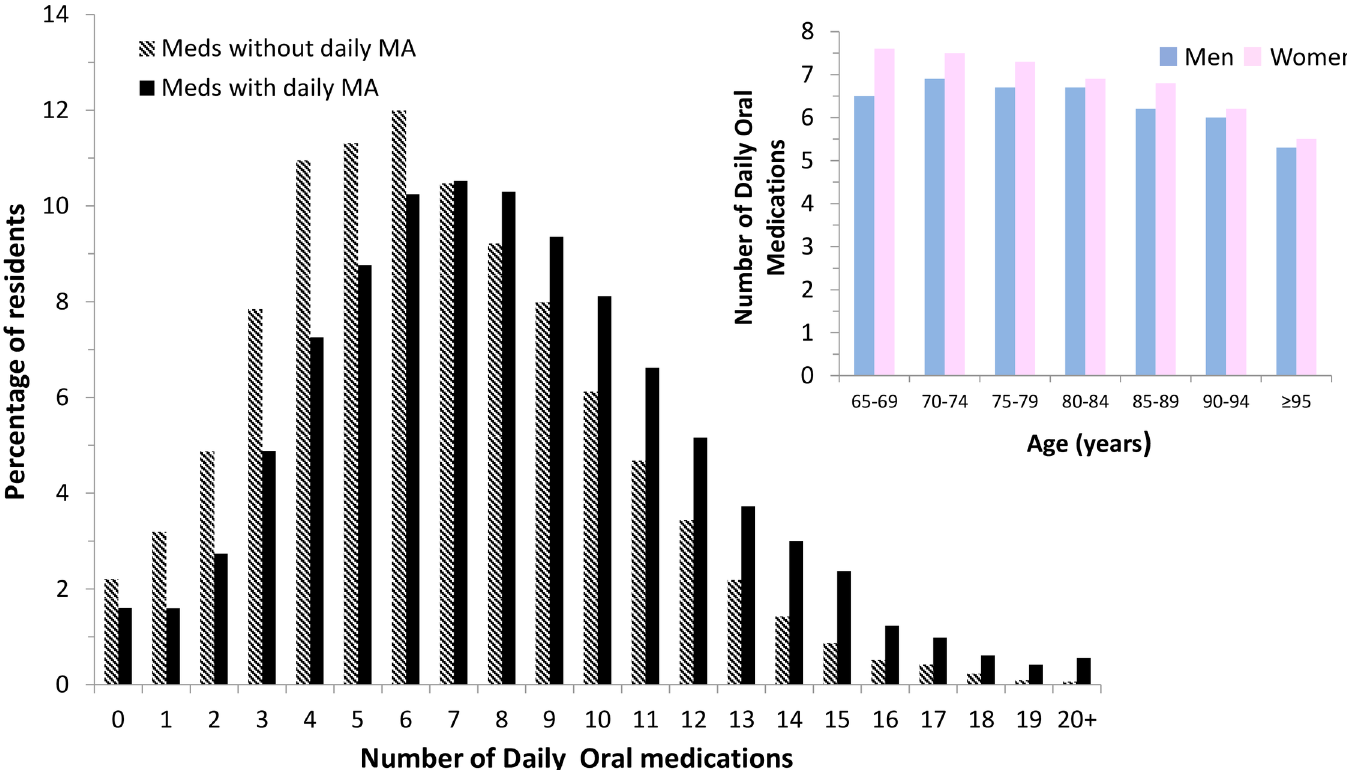
Fig 1. The distribution of the number of chronic daily oral medications for older long-stay nursing homes residents including (solid bars) and excluding (striped bars) daily health maintenance agents (MA) is shown in the larger panel on the left and the mean number of chronic oral daily medications (excluding health maintenance agents) for men (blue) and women (pink) by age group is shown in the smaller inset panel on the right.